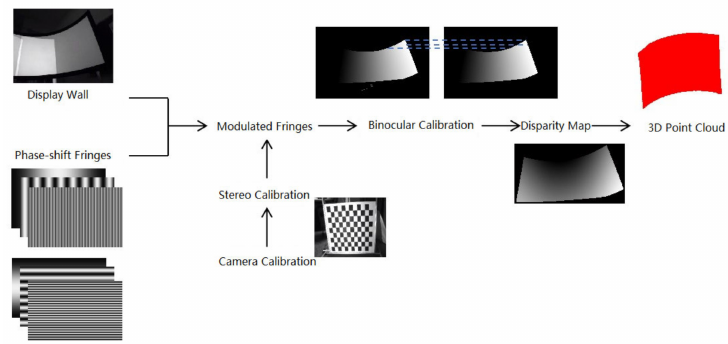
Figure 4. Binocular vision 3D reconstruction method flow chart.